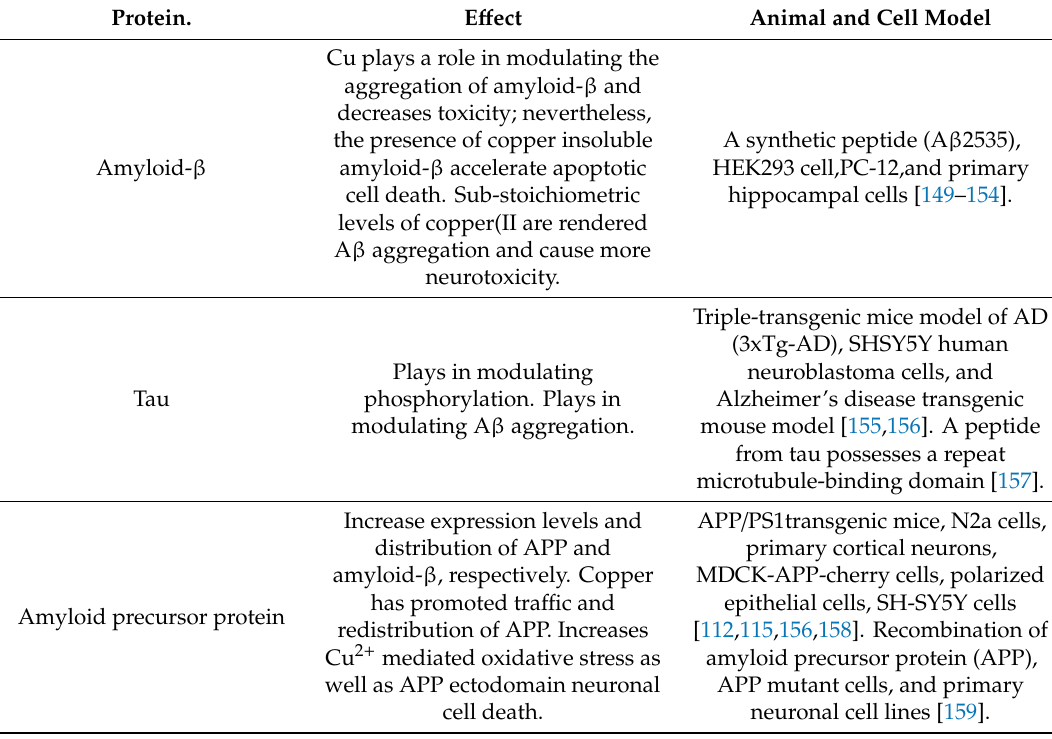
Table 1 . Copper ions’ effects on selected metal-binding proteins implicated in Alzheimer’s disease.